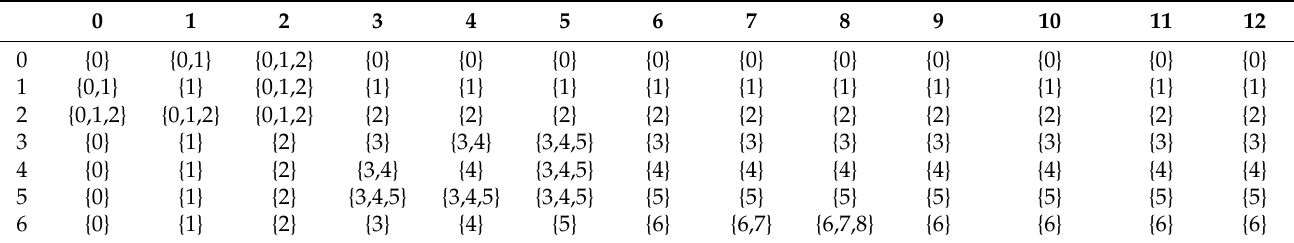
Table 12. CA- semihypergroup of order